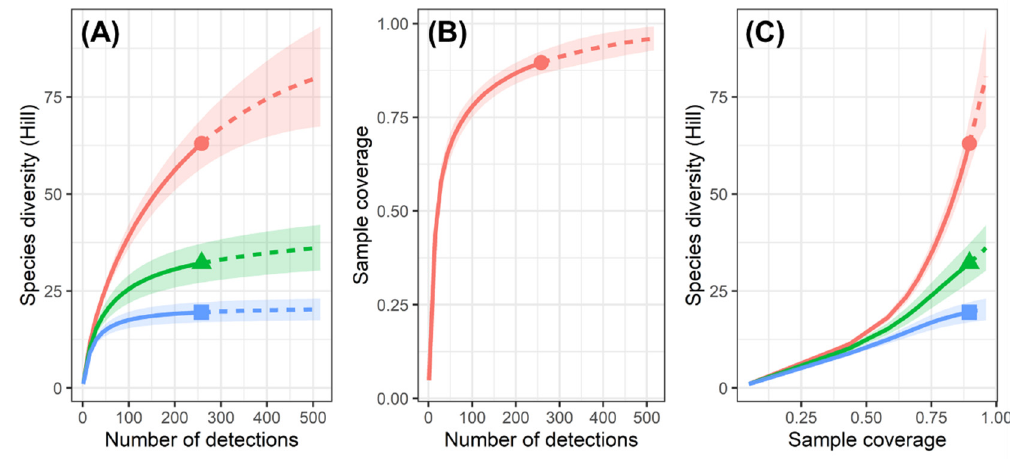
Figure 4. Diversity calculated from cave surveys and the associated sample coverage: ( A ) Species diversity per number of spider detections (occurrences). ( B ) Sample coverage per number of spider detections (occurrences). ( C ) Species diversity by sample coverage. Red lines with terminal circles, green lines with terminal triangles, and blue lines with terminal squares denote Hill-richness, Hill–Shannon diversity, and Hill–Simpson diversity, respectively. Solid lines represent observed diversity, and dashed lines represent extrapolated diversity. Light zones surrounding lines denote 95 % confidence intervals.